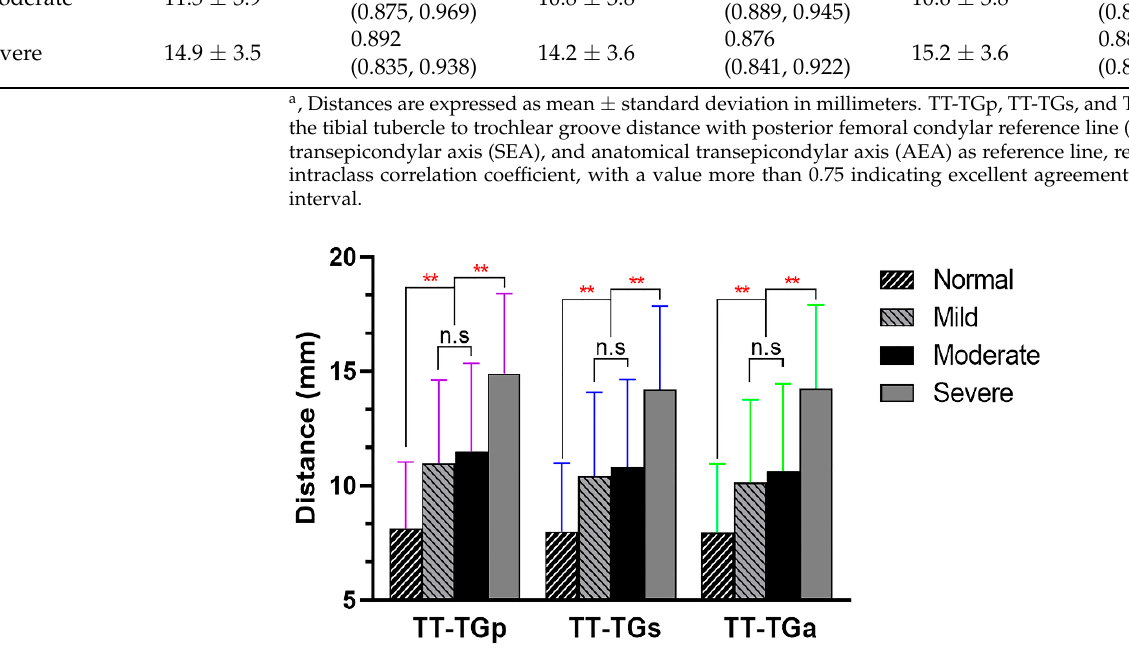
Figure 6. Comparison of the TT-TG distance among different types of trochlear dysplasia (Oswestry-Bristol Classification). n.s, none statistically significant. ** Statistically significant with p < 0.001. Table 6. Inter-observer reliability of the TT-TG distance in different Oswestry-Bristol Classification of trochlear dysplasia a .